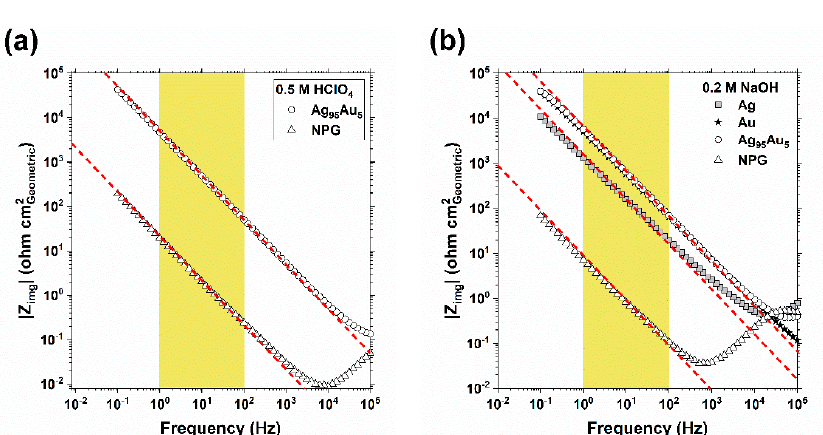
sample is similar to those for flat Ag 95 Au 5 , Ag, and Au surfaces over a wide range of fre-